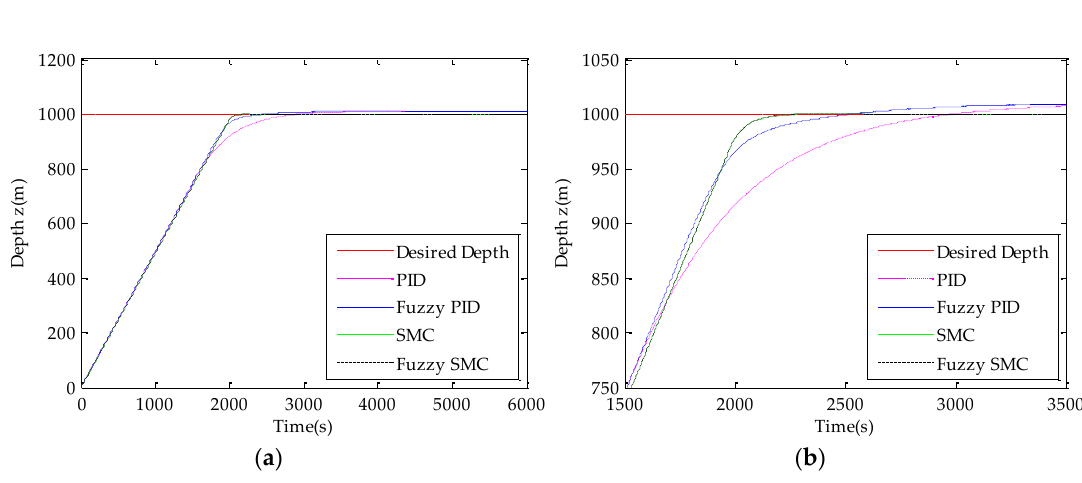
Figure 13. Control response curves with disturbing force. ( a ) Depth response curves. ( b ) Magnified view of depth response curves. Table 8. Characteristic parameter table after adding interference to the four controllers.